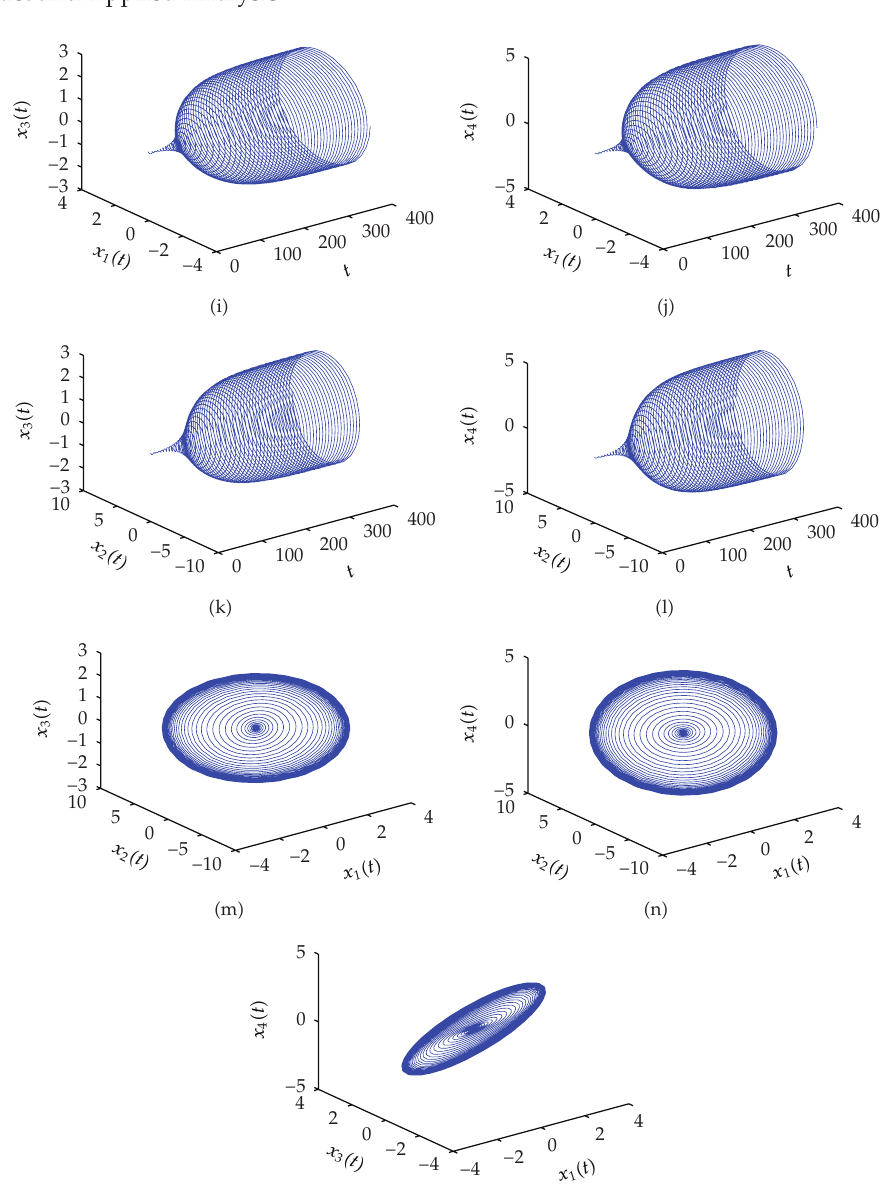
Figure 2: The time histories and phase trajectories of system (cid:7) 4.1 (cid:8) with τ (cid:5) 0 . 8 > τ 0 ≈ 0 . 6801 and the initial value (cid:7) 0.05, 0.05, 0.05, 0.025 (cid:8) . Hopf bifurcation occurs from the equilibrium E 0 (cid:7) 0 , 0 , 0 , 0 (cid:8)